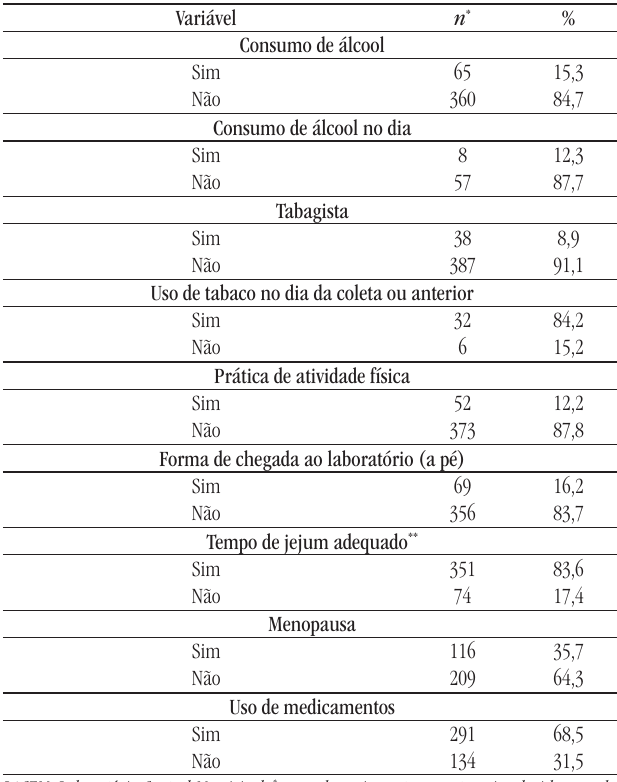
LACEM: Laboratório Central Municipal; * o n pode variar entre as categorias devido a perdas amostrais; ** tempo de jejum até 14